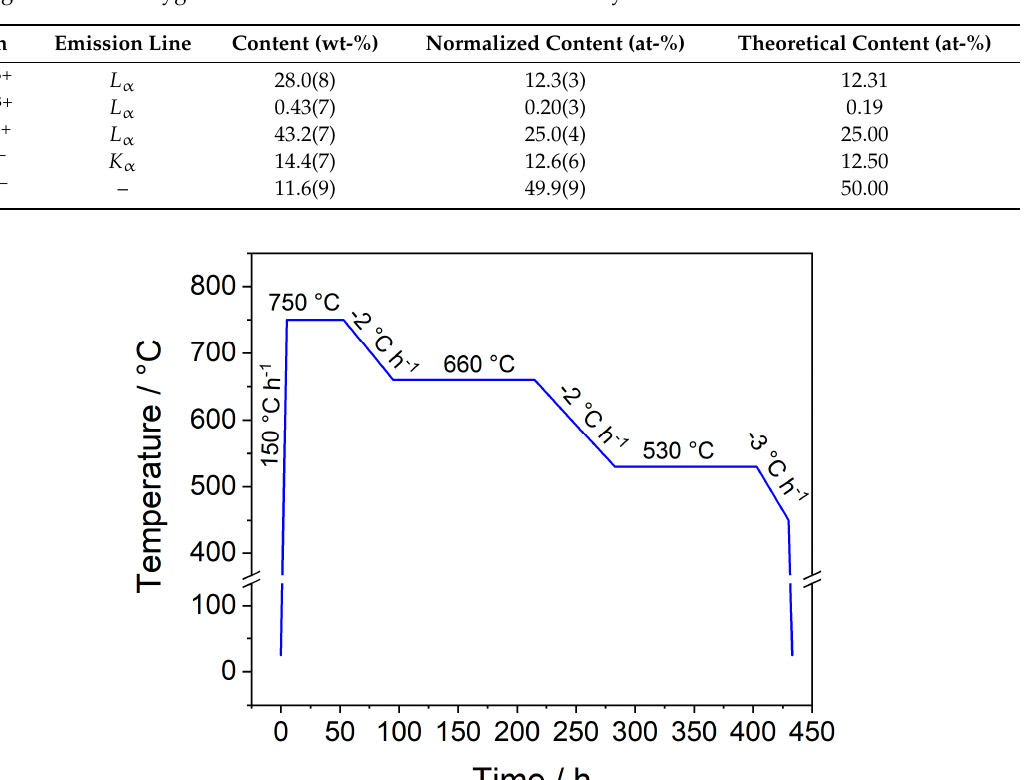
Table A4. Quantitative electron-beam microprobe analysis of TbSb 2 O 4 Br doped with 1.5 at-% Eu 3 +